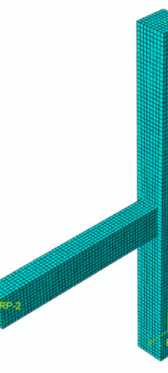
Figure 5. Grid division.